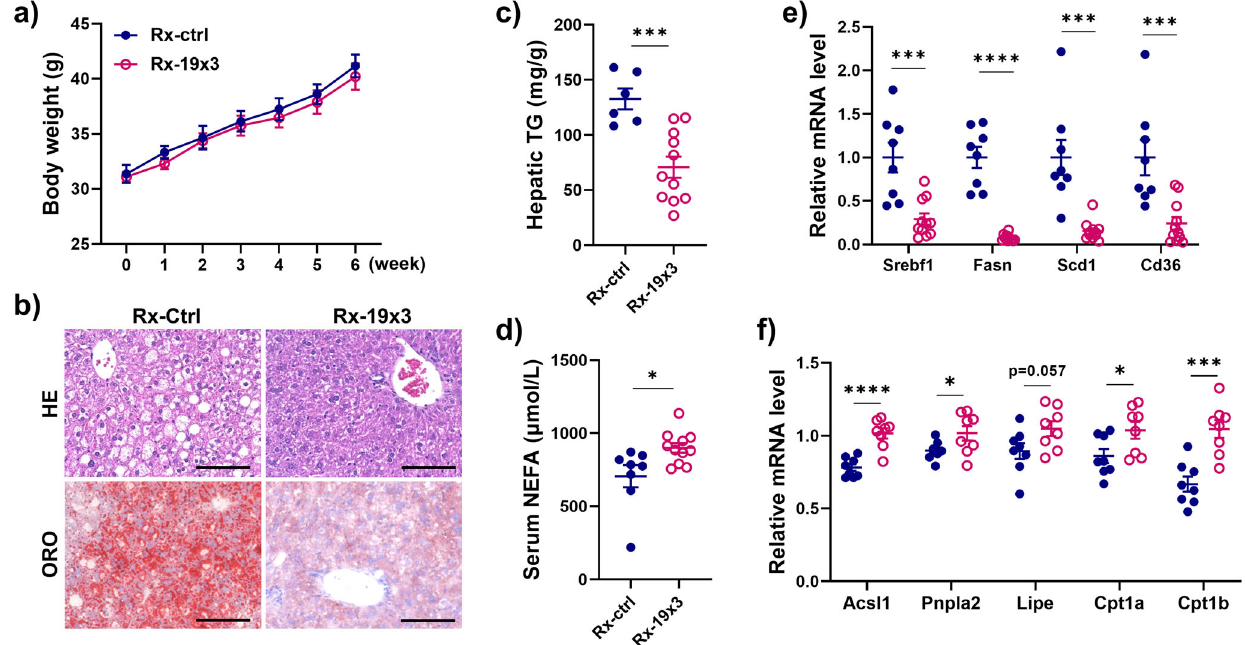
Fig. 4 AAV-CasRx mediated Gm19619 knockdown in HFD-fed mice signi fi cantly improved the mice lipid metabolism. a The body weight of Gm19619 knockdown (CasRx-19×3) ( n = 11) and control ( n = 8) mice. b Representative images of liver sections by H&E and oil red o staining, respectively. Scale bar, 100 μ m. c The serum level of triacylglycerol (TG) in CasRx-19×3 ( n = 11) and CasRx-ctrl ( n = 6) mice. d The serum level of NEFA in CasRx-19×3 ( n = 11) and CasRx-ctrl ( n = 8) mice. e The relative mRNA levels of some lipogenesis genes and Cd36 in CasRx-19×3 ( n = 11) and CasRx-ctrl ( n = 8) mice. f The relative mRNA levels of several lipolysis and beta-oxidation genes in CasRx-19×3 and CasRx-ctrl mice ( n = 8). Two-tailed unpaired t -test. Error bars represent the SEM. * P < 0.05, *** P < 0.001, and **** P < 0.0001.